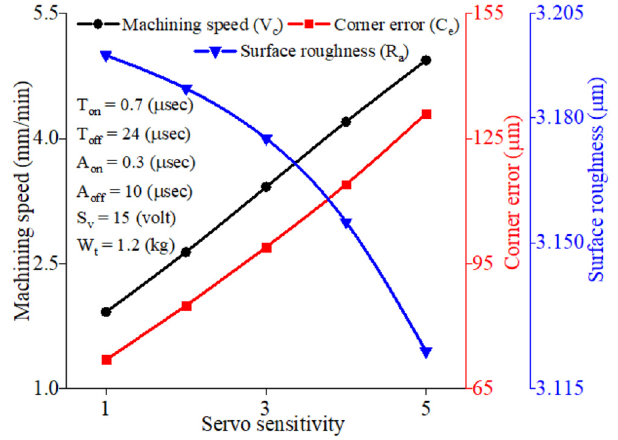
Fig. 6. Effect of servo sensitivity on machining speed, corner error and surface